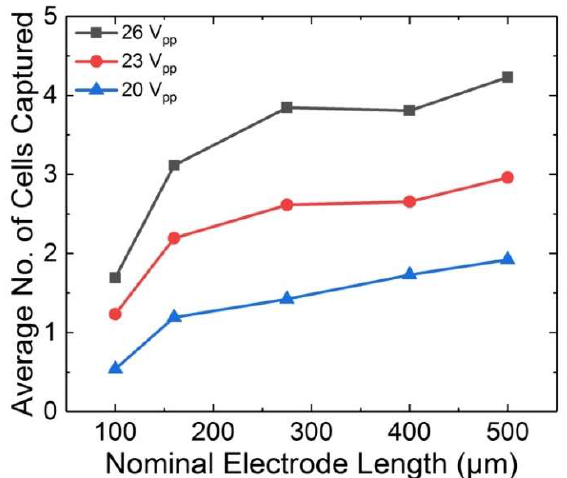
Figure 3. Plot of average cell cluster size at each BPE length (14 total BPEs of each length over two